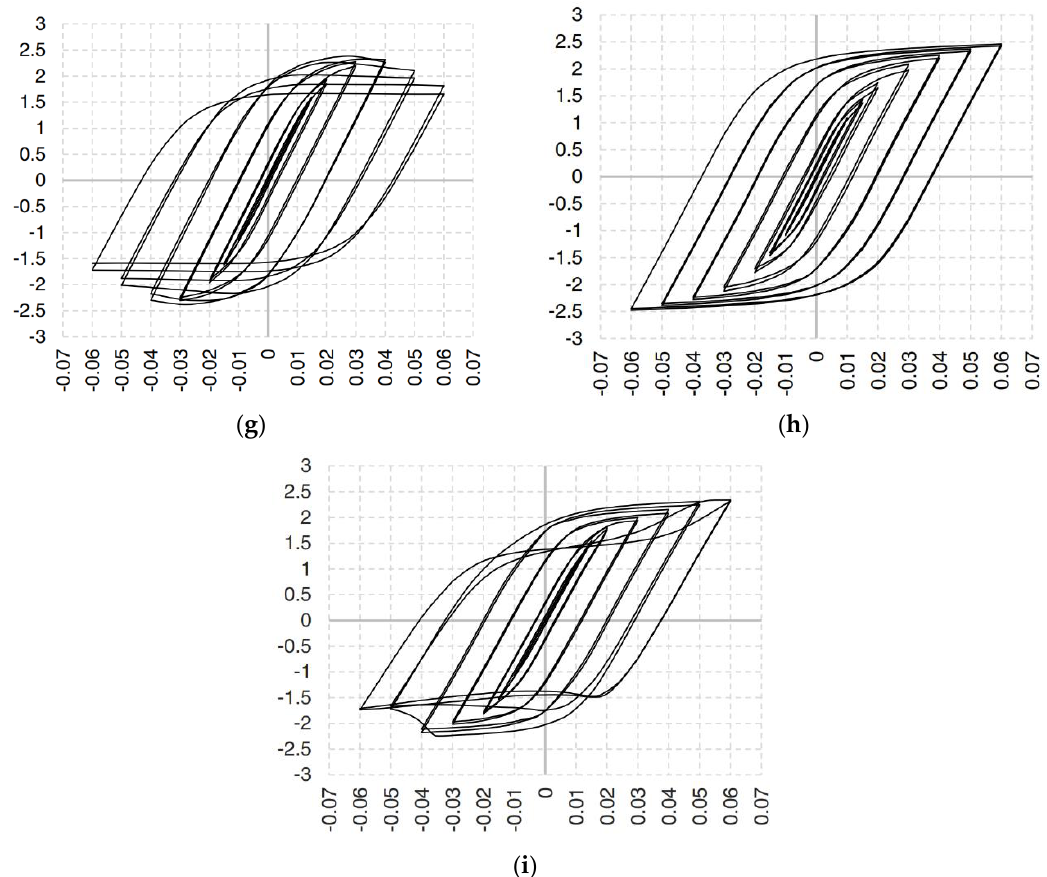
Figure 18. Normalized moment vs. rotation curves: ( a ) P1 model, ( b ) P2 model, ( c ) P3 model, ( d ) P4 model, ( e ) P5 model, ( f ) P6 model, ( g ) P7 model, ( h ) P8 model, ( i ) P9 model.